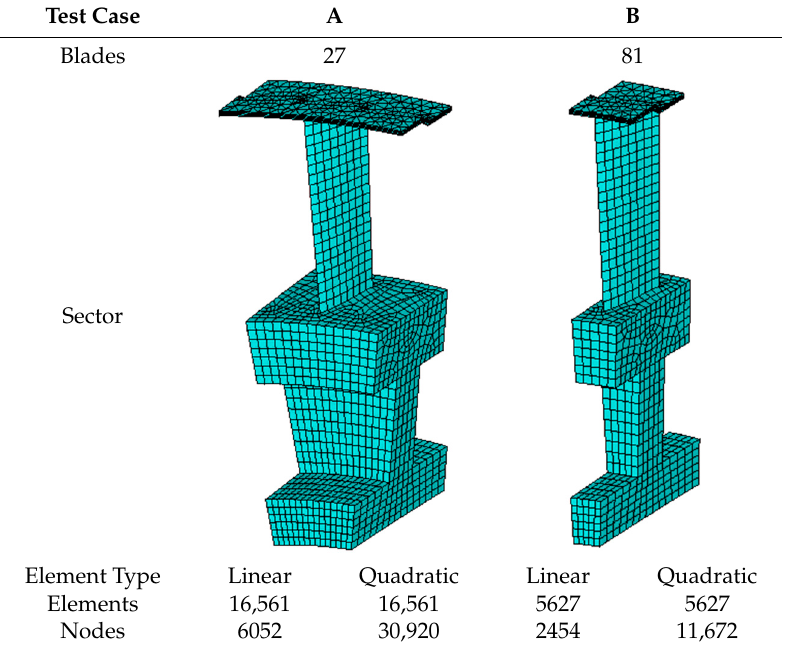
Table 2. List of ROMs generated and used for comparison.